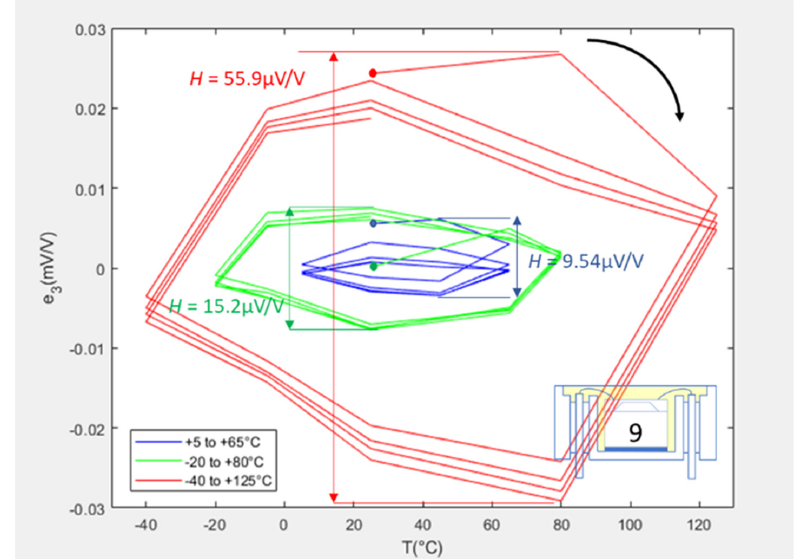
Figure 8. Error plots for SE #9 when L2 packaged.